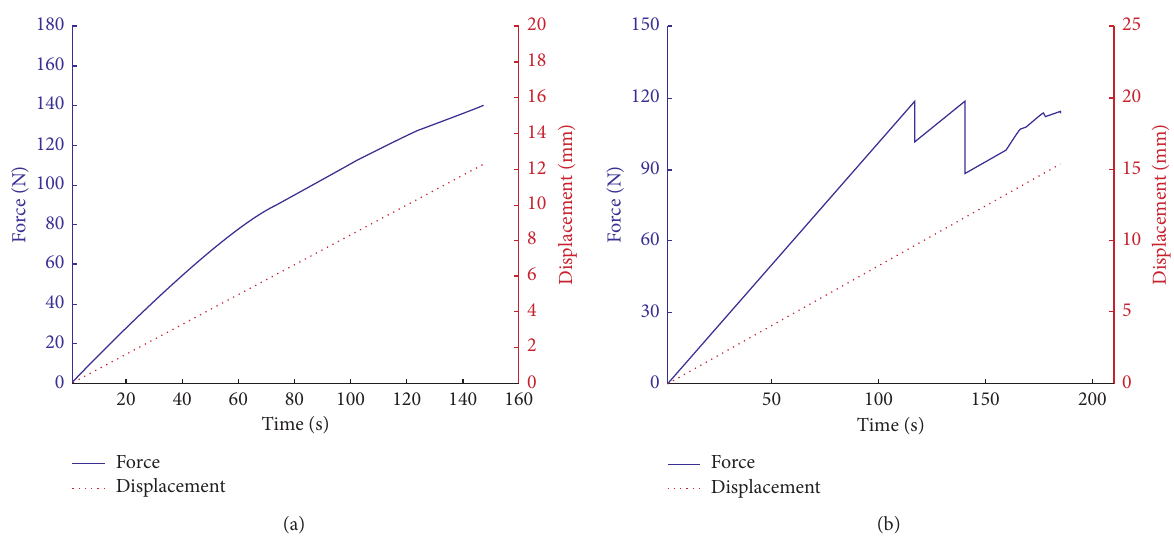
Figure 7: The time curve of maximum loading force and displacement. (a) [0